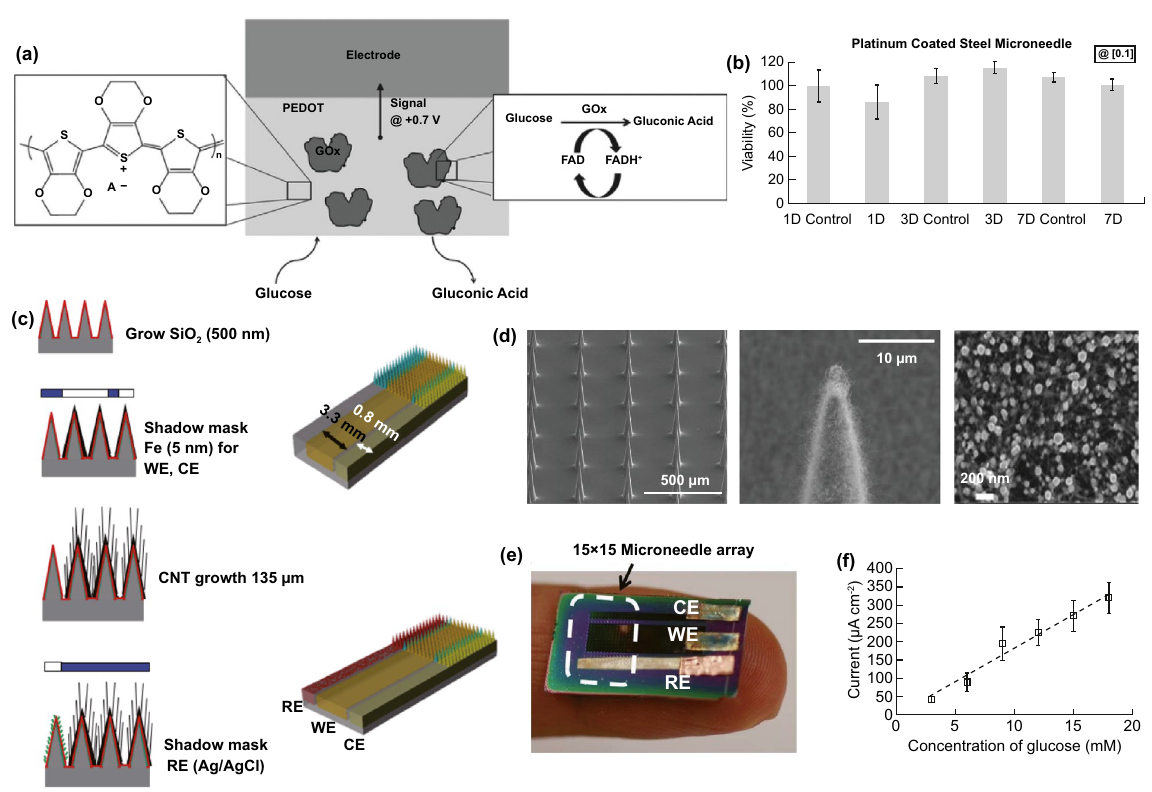
Fig. 13 Microneedle‑based biosensors for glucose monitoring. a Schematic image of glucose‑Sensing. b Representative concentration curves of platinum‑coated steel microneedle sensors [236]. c–f An enzyme‑free glucose electrochemical sensor with WE, RE, and CE fabricated on an entire microneedle patch. c Fabrication sequence. d SEM images of microneedle arrays (left), the microneedle tip with MWCNT grown on (mid‑ dle), and Pt nanoparticles electrodeposited in MWCNT (right). e The fabricated 3‑electrode microneedle glucose sensor. f Current response of the sensor as a function of glucose concentration in PBS [237]. Reproduced with permission from Refs. [236, 237], copyright (2014) John Wiley and Sons Publishing Group and (2013) Multidisciplinary Digital Publishing Institute Publishing